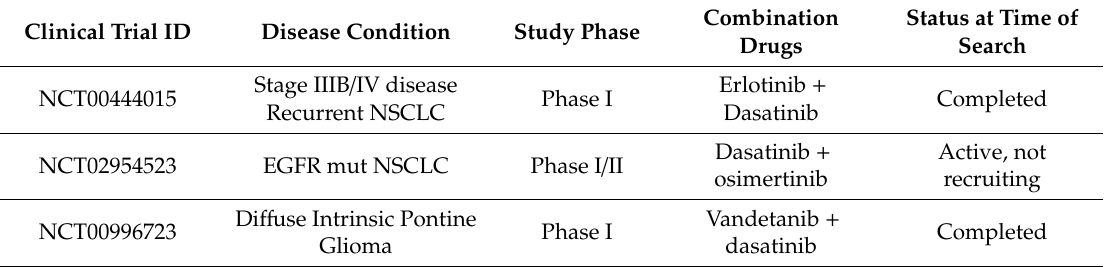
Table 3. Ongoing Clinical